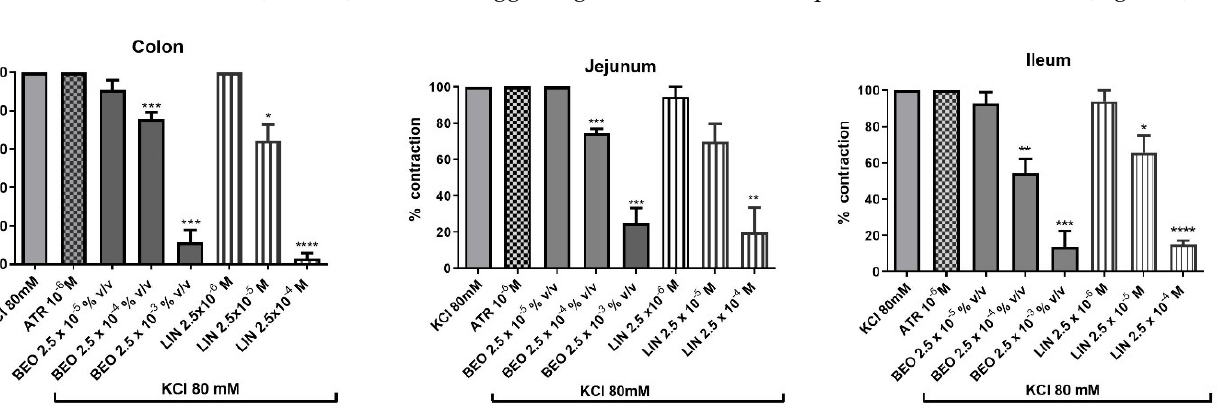
Figure 3. Effect of BEO or linalool on KCl-evoked contraction in colon, jejunum and ileum of rat. Each column represents the mean of 3–6 rats. Vertical lines show standard error of mean. * p < 0.05, ** p < 0.01, *** p < 0.001 and **** p < 0.0001 show the statistical significance between the concentrations of BEO tested on ACh-contraction versus ACh-contraction control ( t -tests). KCl = potassium cloride, ATR = atropine, BEO = bergamot essential oil, LIN =